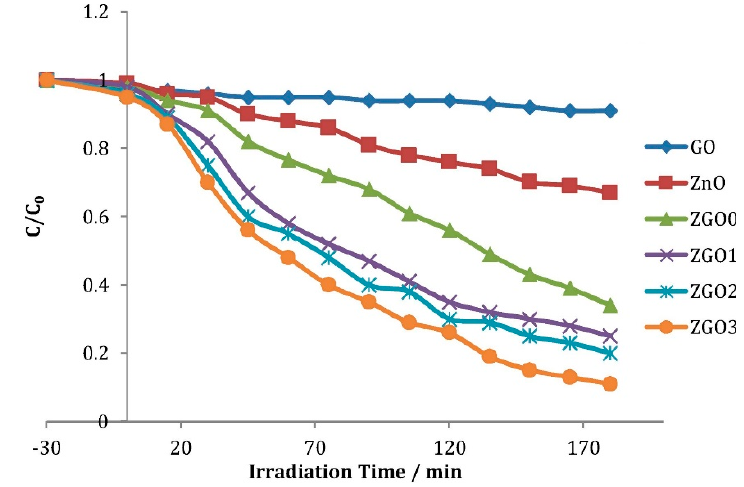
Figure 28. Photocatalytic degradation of 2,4-D (10 ppm) as the variation of C/C 0 with irradiation time in the presence of GO, ZnO, ZGO0, ZGO1, ZGO2, and ZGO3. Reprinted with permission from [82].